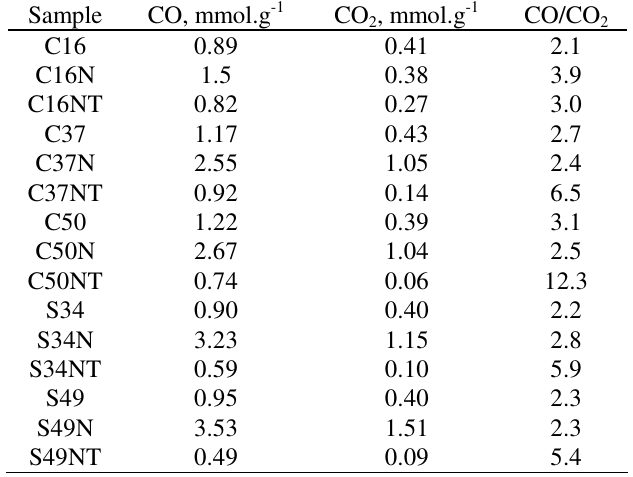
Table 2 . Amount of CO and CO evolved during the TPD experiments on the as-synthesized, 2 oxidized and heat treated activated